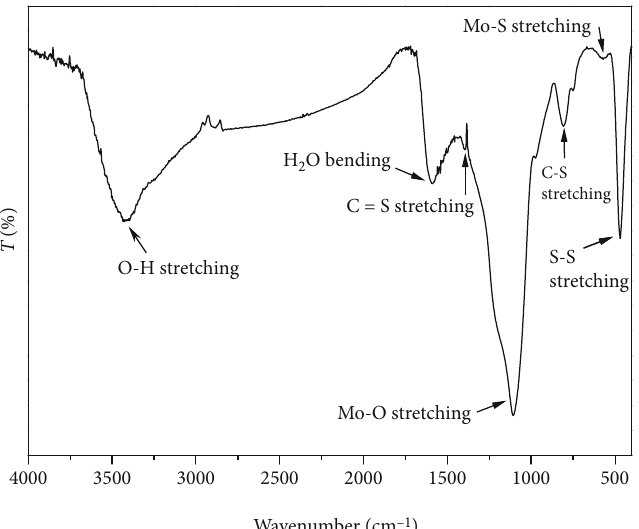
Figure 1: FTIR spectrum of MYNS.